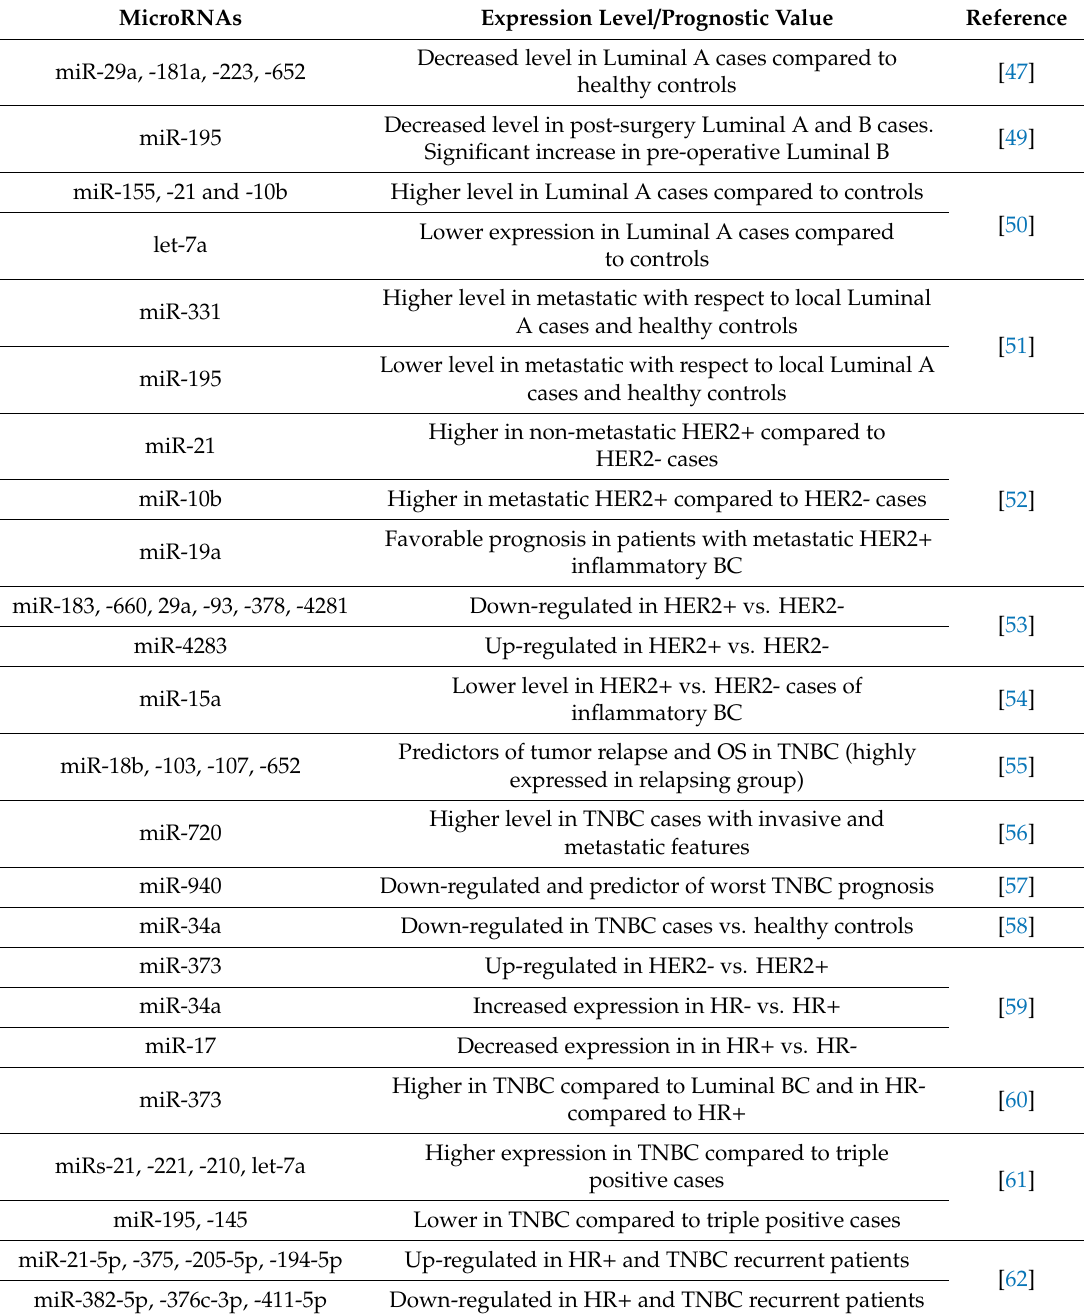
Table 1. Circulating microRNAs identified in the di ff erent breast cancer